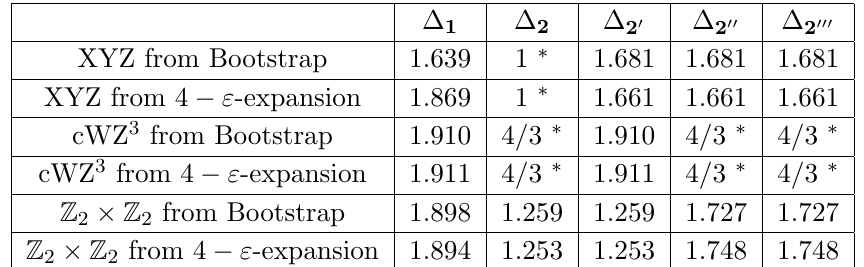
Figure 10 . Left: upper bounds on the chiral bilinear OPE coe(cid:14)cient squared (cid:21) 2 in the fundamental domain F de(cid:12)ned in (cid:12)gure 1, computed using the G (cid:13)avor symmetry crossing equations with (cid:3) = 19. Right: 2-loop 4 (cid:0) " -expansion values for this quantity. In all plots the cross, circle, and triangle denote the enhanced symmetry points (cid:28) = 1 (cid:6) and XYZ models respectively.